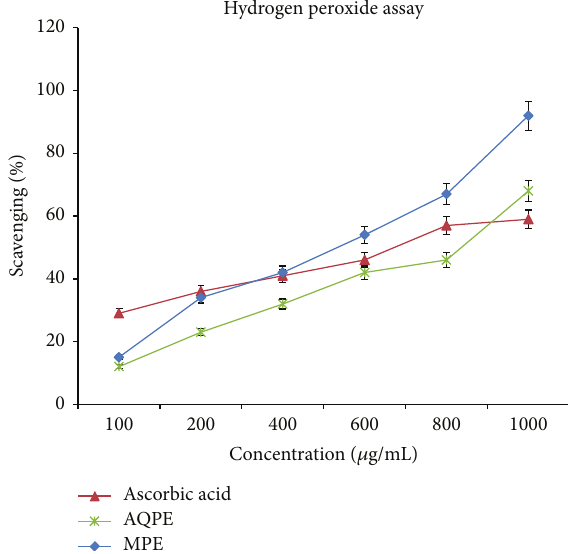
Figure 2: Hydrogen peroxide scavenging of the aqueous and methanolic extract of P. granatum in comparison with a standard (ascorbic acid) at 𝜆 = 230 nm.